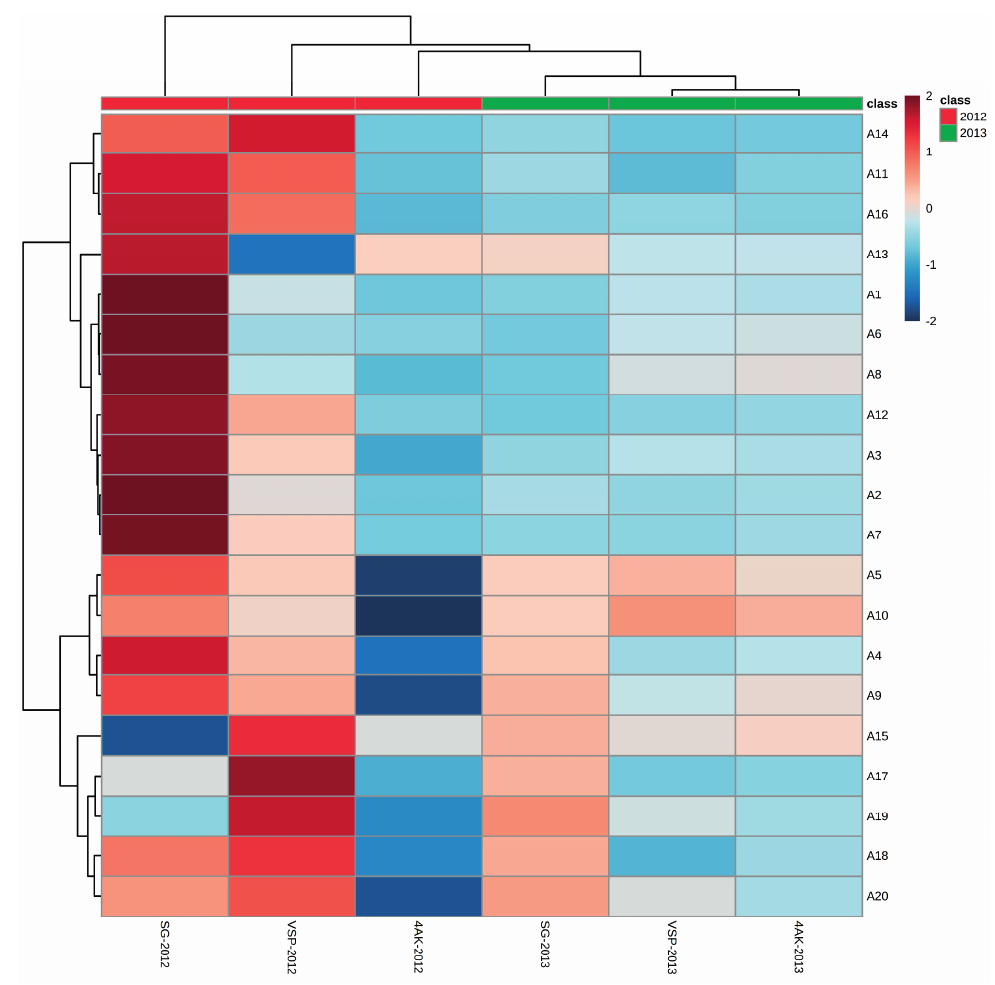
Figure 3. The hierarchically clusteredheat map of individual anthocyanin concentrations with samples in rows and compounds in columns. Color bar defines concentration fold